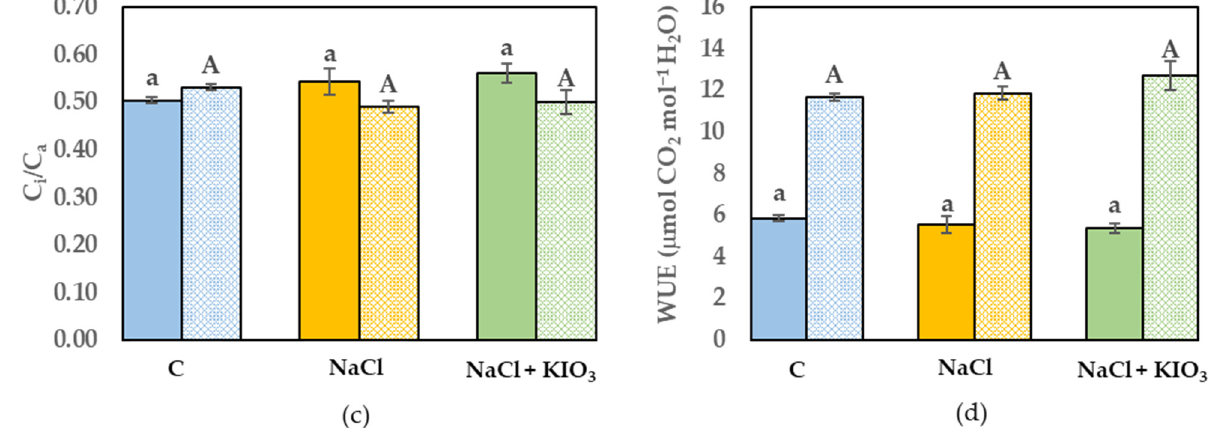
Figure 1. ( a ) Net photosynthesis (A N ); ( b ) stomatal conductance (G s ); ( c ) intercellular to ambient CO 2 concentration ratio (C i /C a ); ( d ) instantaneous water use efficiency (WUE) measured in plants ferti- lized with nutrient solution (C), in plants fertilized with nutrient solution plus salt (NaCl), and in plants fertilized with nutrient solution plus salt and iodine (NaCl + KIO 3 ). Filled bars: measurements to ambient CO 2 ; cross-linked bars: measurements to elevated CO 2 . Data are means ± SE. Different letters indicate statistical difference among treatments ( p < 0.05).